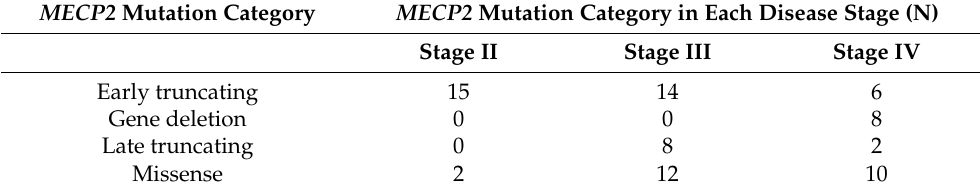
Table 3. Distribution of MECP2 mutation categories for each RTT disease stage.